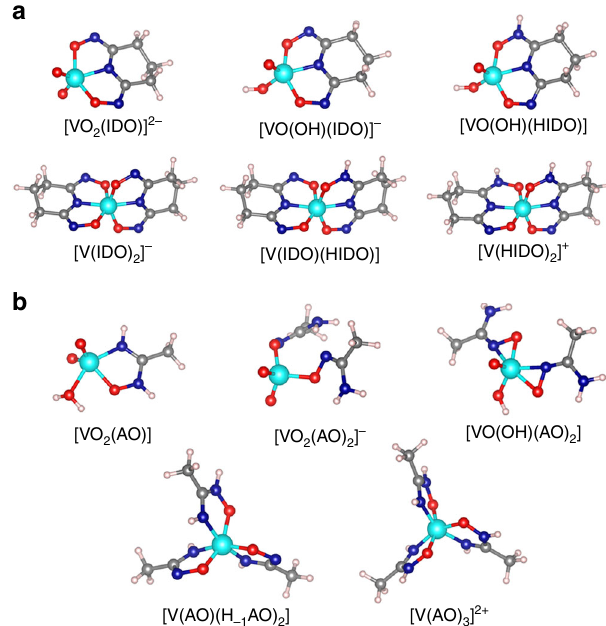
Fig. 2 DFT-optimized geometries of V(V) complexes. a V(V) complexes with glutaroimide-dioxime (H 3 IDO). b V(V) complexes with acetamidoxime (HAO). Color legend: V(V), cyan; O, red; N, navy blue; C, gray; H,